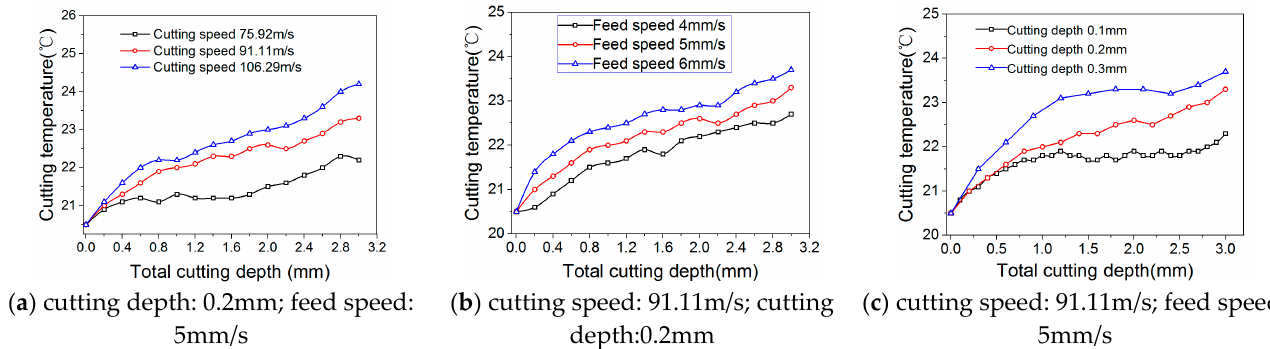
Figure 9. Measurement curves of cutting temperature under different ( a ) cutting speed v s ; ( b ) feed speed v w ; ( c ) cutting depth a p